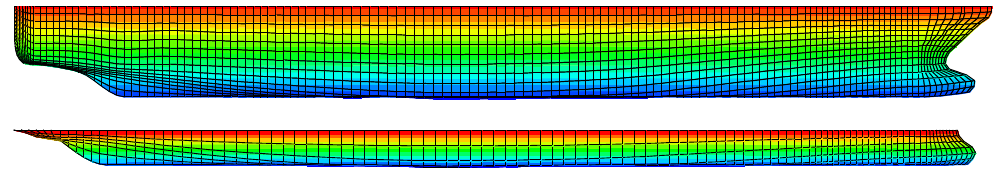
Figure 4. Hydrodynamic calculation grid.